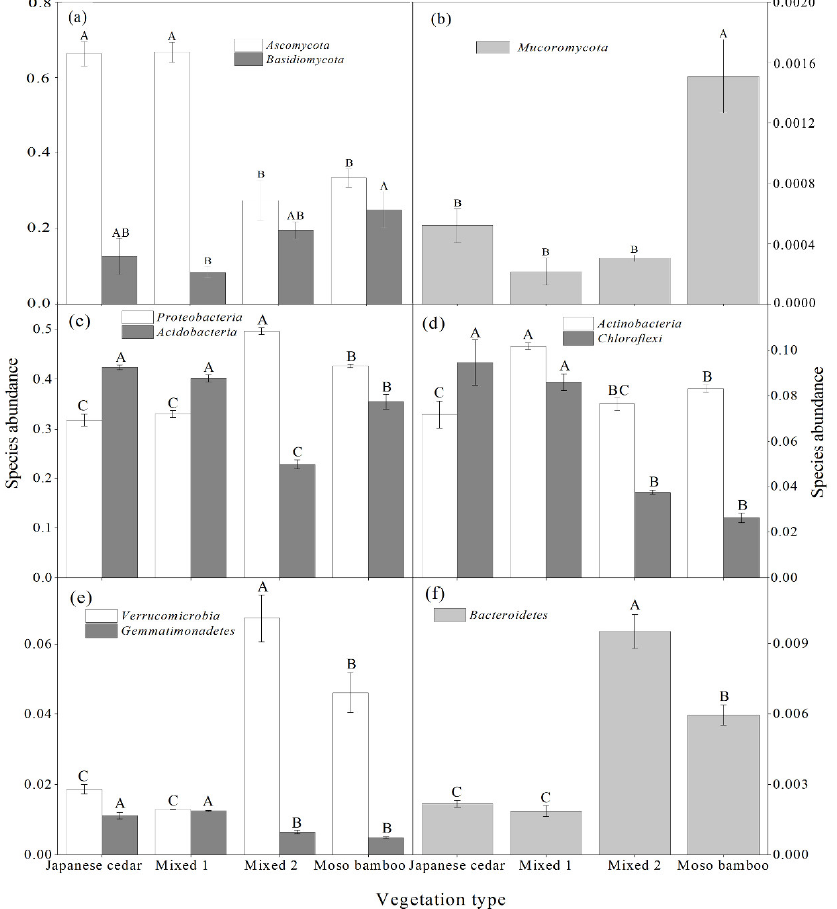
Figure 3. Effect of different vegetation types on species abundance of soil fungal and bacterial at the phylum level (means ± se). ( a ) Fungal species Ascomycota and Asidiomycota , ( b ) fungal species Mucoromycota , ( c ) bacterial species Proteobacteria and Acidobacteria , ( d ) bacterial species Actinobacteria and Chloroflexi , ( e ) bacterial species Verrucomicrobia and Gemmatimonadetes , ( f ) bacterial species Bac- teroidetes . Different letters above columns in the same color indicate significantly different.